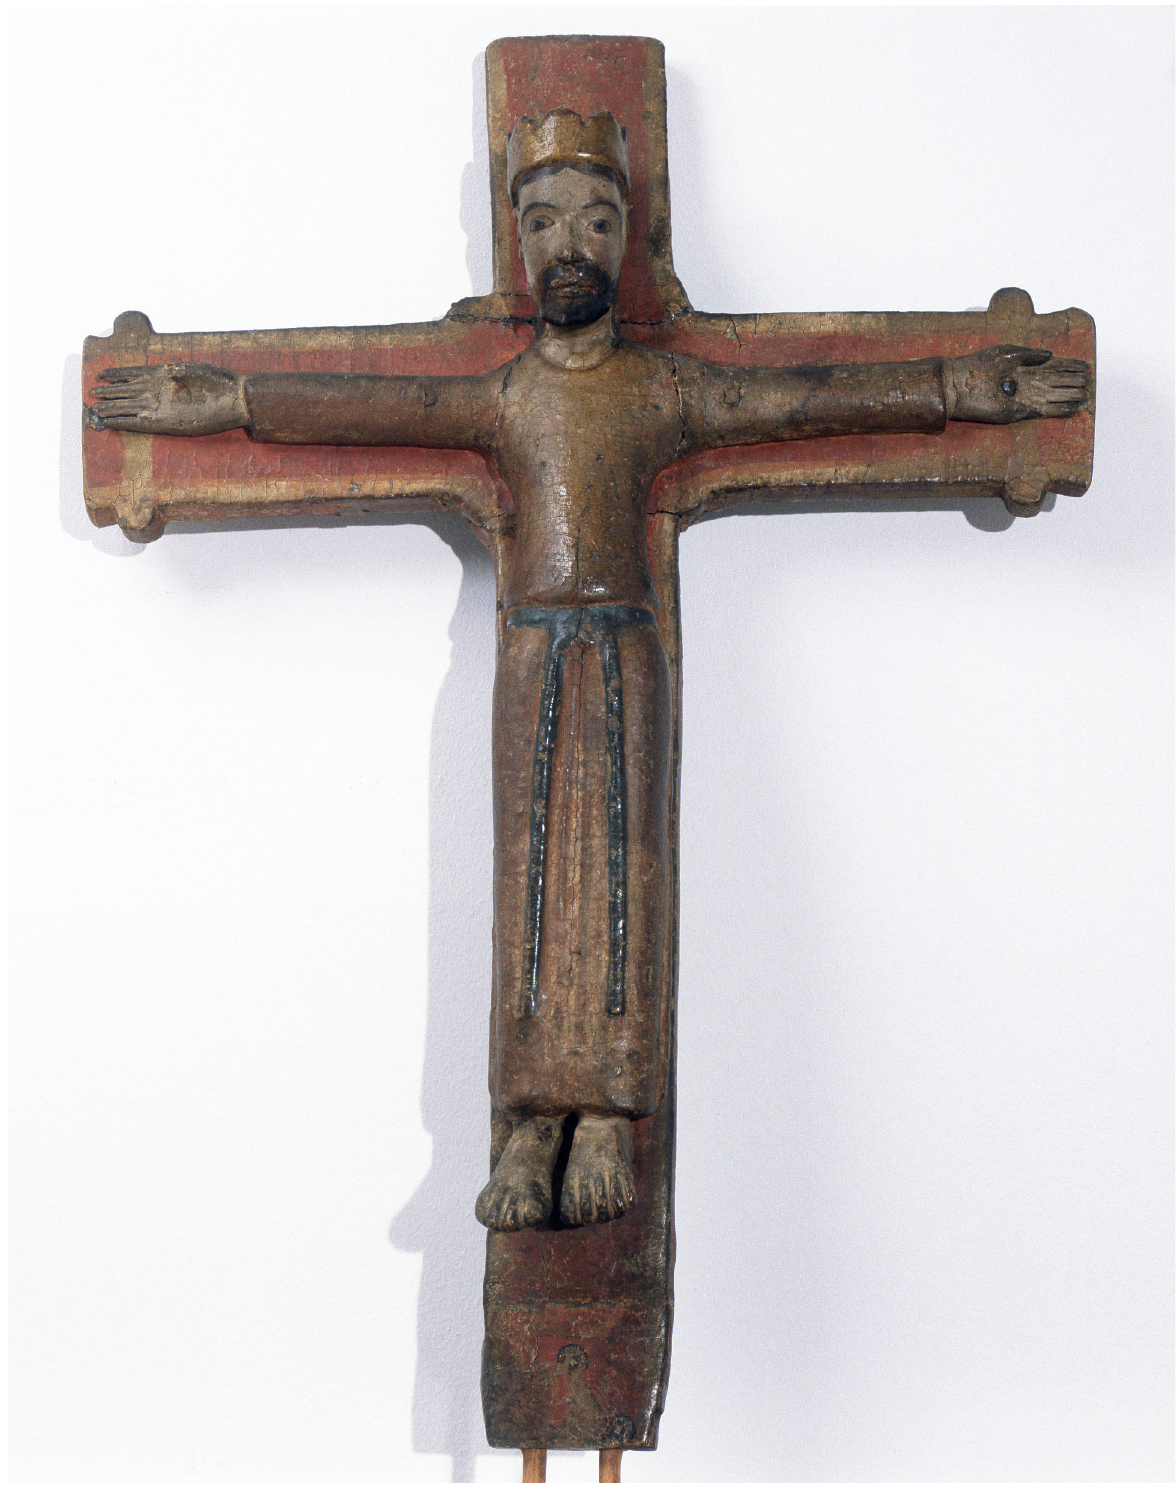
Figure 3. Majestad de Travesseres , 1200–1250. Museu Nacional d’Art de Calalunya (Barcelona). (Source: Web del Museu Nacional d’Art de Catalunya de Barcelona, https://www.museunacional.cat) (accessed on 5 May 2022).